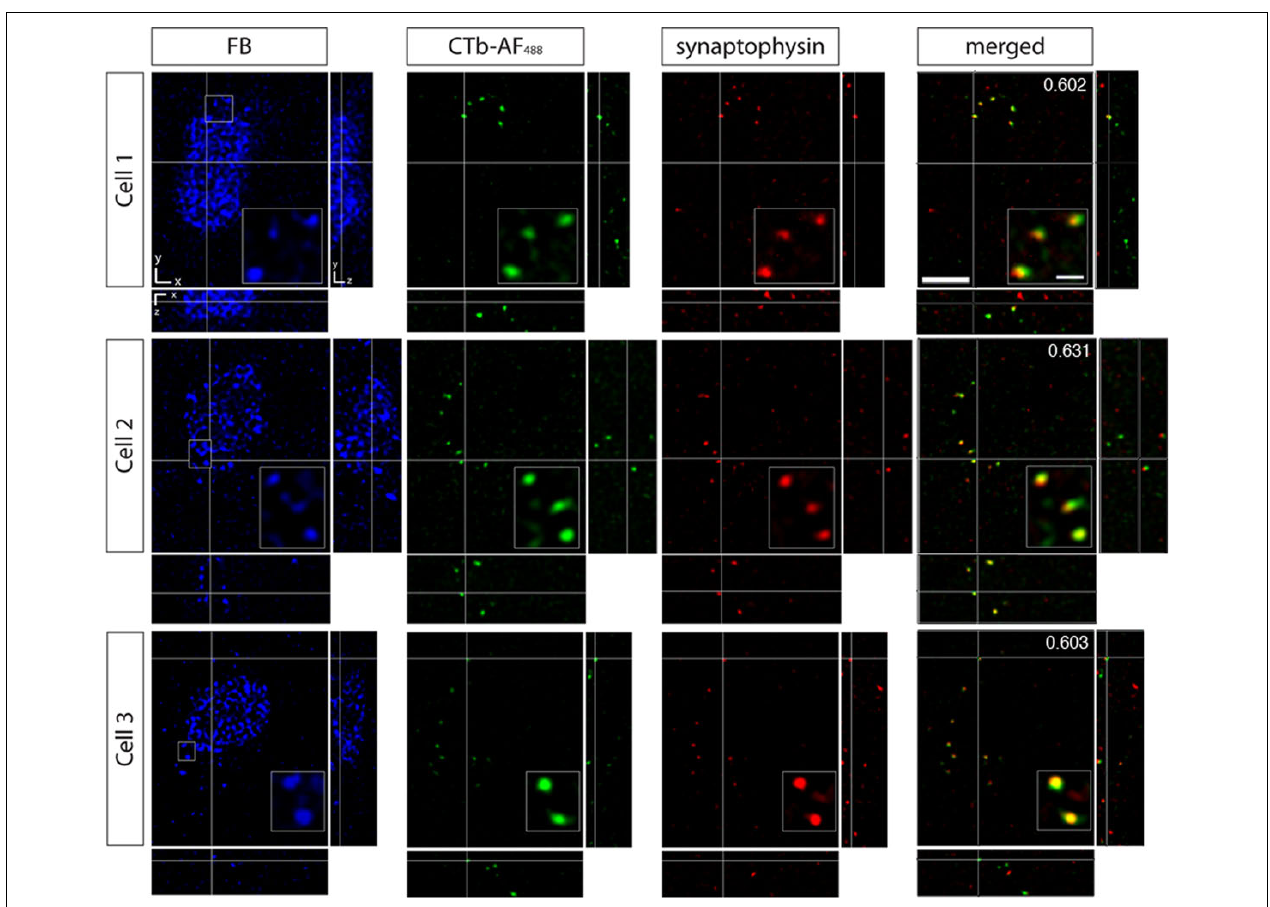
FIGURE 9 | Confocal micrographs of three area MT relay cells in the left hemisphere pulvinar nucleus (PIm) surrounded by retinal terminals from contralateral retinal afferents colocalized with synaptophysin. In PIm, contralateral retinal terminals (green) synapse onto the cell bodies of Fast Blue-labeled area MT relay cells as confi rmed by colocalization with synaptophysin (red) resulting in overlapping (yellow) puncta. Overlapping puncta was seen to be concentrated at one end of the cell (Cell 1) and surrounding the cell body. In this example, area MT of the left hemisphere was